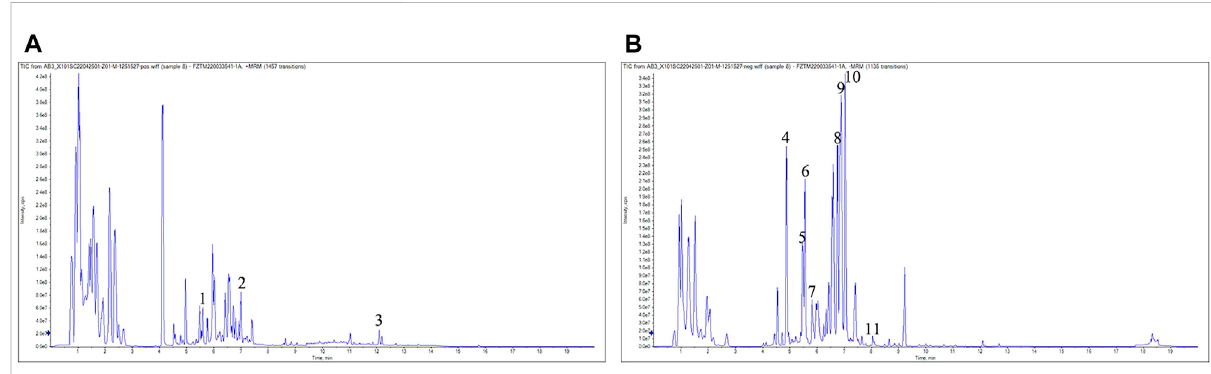
FIGURE 1 LC-MSanalysis. (A) positivemode (B) negativemode.1)1-Caffeoylquinicacid(rt=5.46 min),2)IsoferulicAcid(rt=7.008 min),3)Costunolide(rt = 12.083 min), 4) Neochlorogenic acid (rt = 4.879 min), 5) Chlorogenic Acid (rt = 5.37 min), 6) 3-O-Feruloylquinicacid (rt = 5.55 min), 7) Caffeicacid (rt = 5.801 min), 8) Isochlorogenic acid B (rt = 6.768 min), 9) 1,5-Dicaffeoylquinic acid (rt = 7.676 min), 10) Isochlorogenic acid C (rt = 7.053 min), 11) Scoparone (rt = 7.935